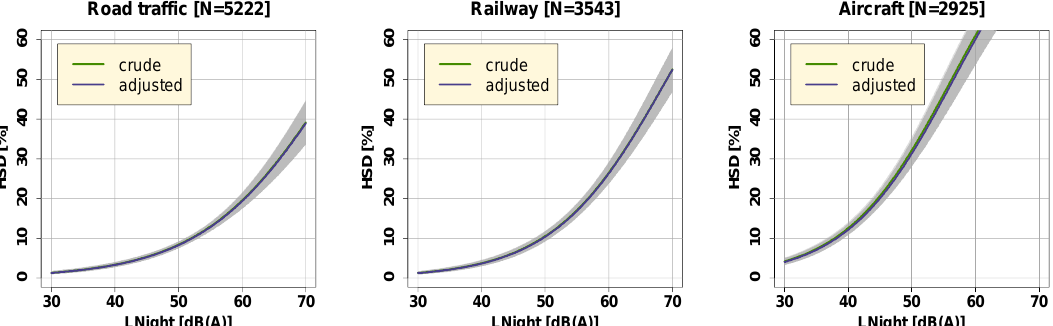
Figure 3. %HSD as function of LNight at the maximum façade point for road traffic, railway, and aircraft noise. The curves reflect both the crude and adjusted model with covariates centered on the mean (i.e., for the road traffic model: male sex = 0.47; age = 49; German language = 0.66; interview mode postal = 0.78 – for the railway model: male sex = 0.49; age = 48; German language = 0.69; interview mode postal = 0.77 – for the aircraft model: male sex = 0.47; age = 48; German language = 0.74; interview mode postal = 0.76.). The curves include 95% (overlapping) confidence intervals as shaded areas.